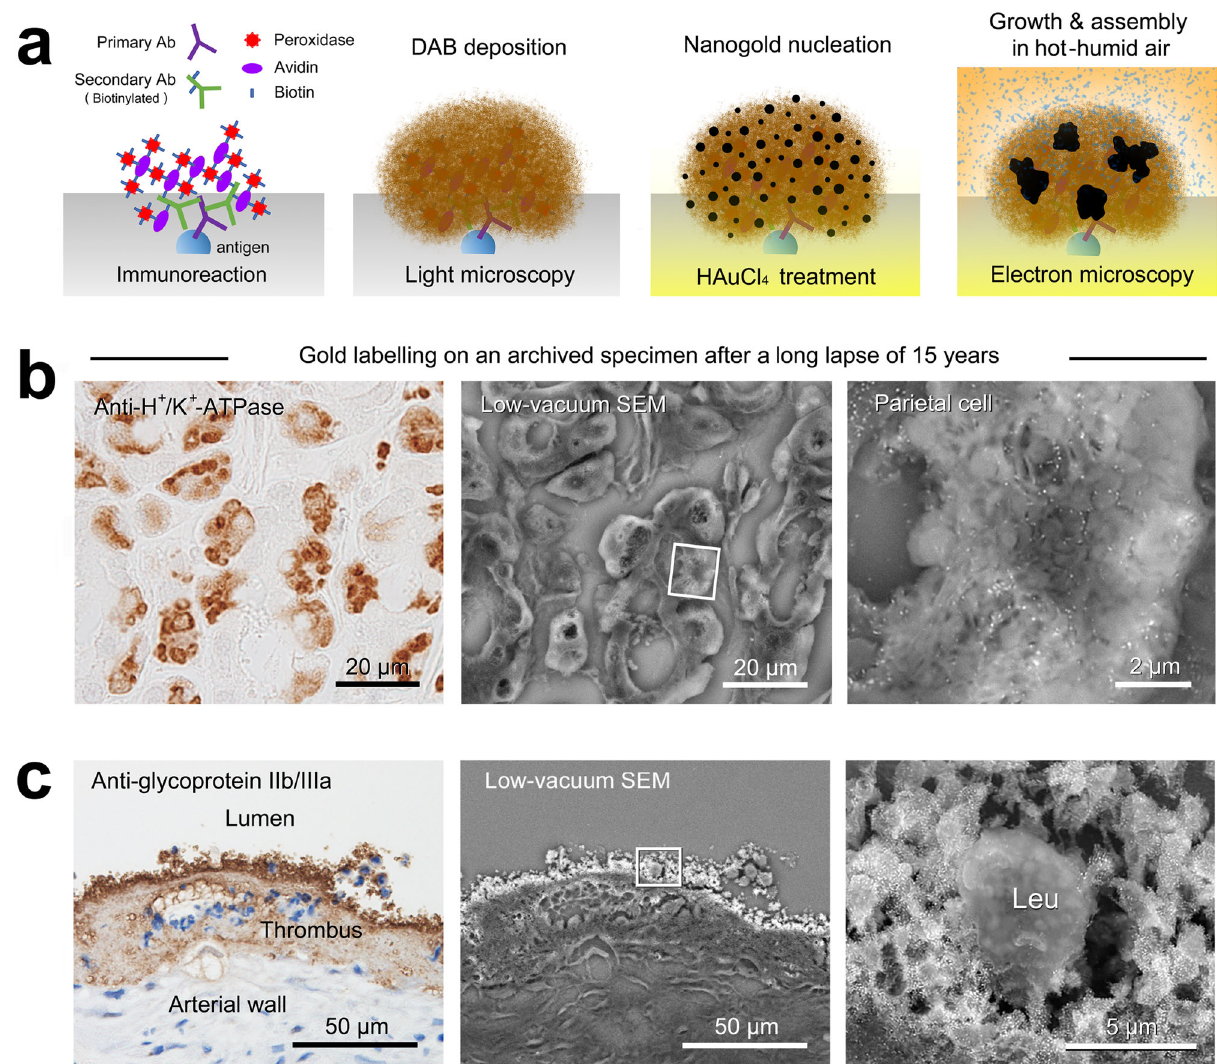
Fig. 9 Illustration of in situ nanogold labeling and biomedical applications. a Proposed illustration of the in situ nanogold labeling. Nanogold particles nucleated from HAuCl 4 in situ among the DAB deposition sites. The secondary growth and aggregation that occur in hot-humid conditions are suf fi cient for low-vacuum SEM observation. b Rat gastric parietal cell. Retrospective nanogold labeling of H + /K + -ATPase on a valuable archived specimen after a long lapse of 15 years (i.e., 15 years old-DAB depositions). c Pathological application to rabbit arterial thrombosis. Note the intense labeling of glycoprotein IIb/ IIIa expressed on the platelets surrounding the leukocyte (Leu). The cell nuclei were stained with hematoxylin for